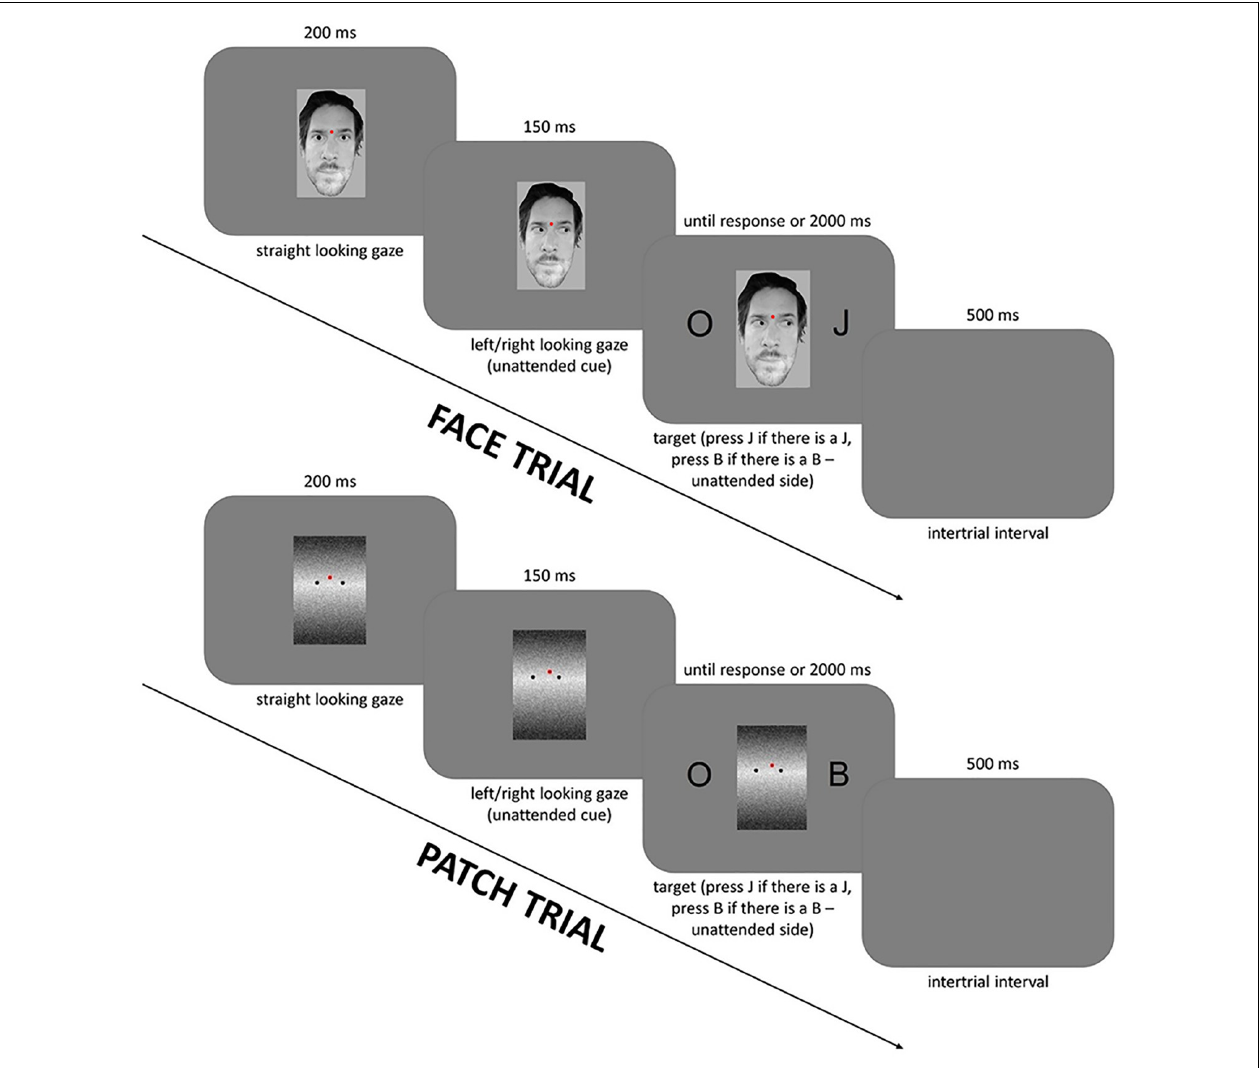
FIGURE 1 | Experimental design: the sequence and timing of stimuli in the face cued trials (top row) and the patch cued trials (bottom row). The figure is similar but not identical to the original image and is therefore for illustrative purposes only.